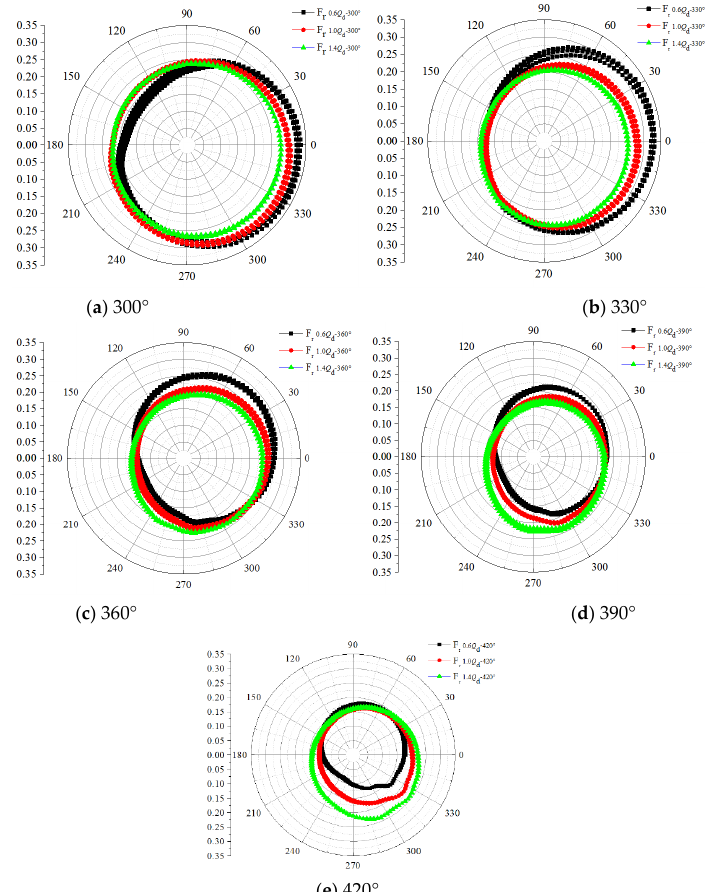
Figure 12. Radial forces of the impellers with different blade wrap angles according to the rotation of the impeller. Figures 13 and 14 show the vector and pressure contour of the single blade centrifugal pump with different wrap angles. It can be seen from the vector diagram that